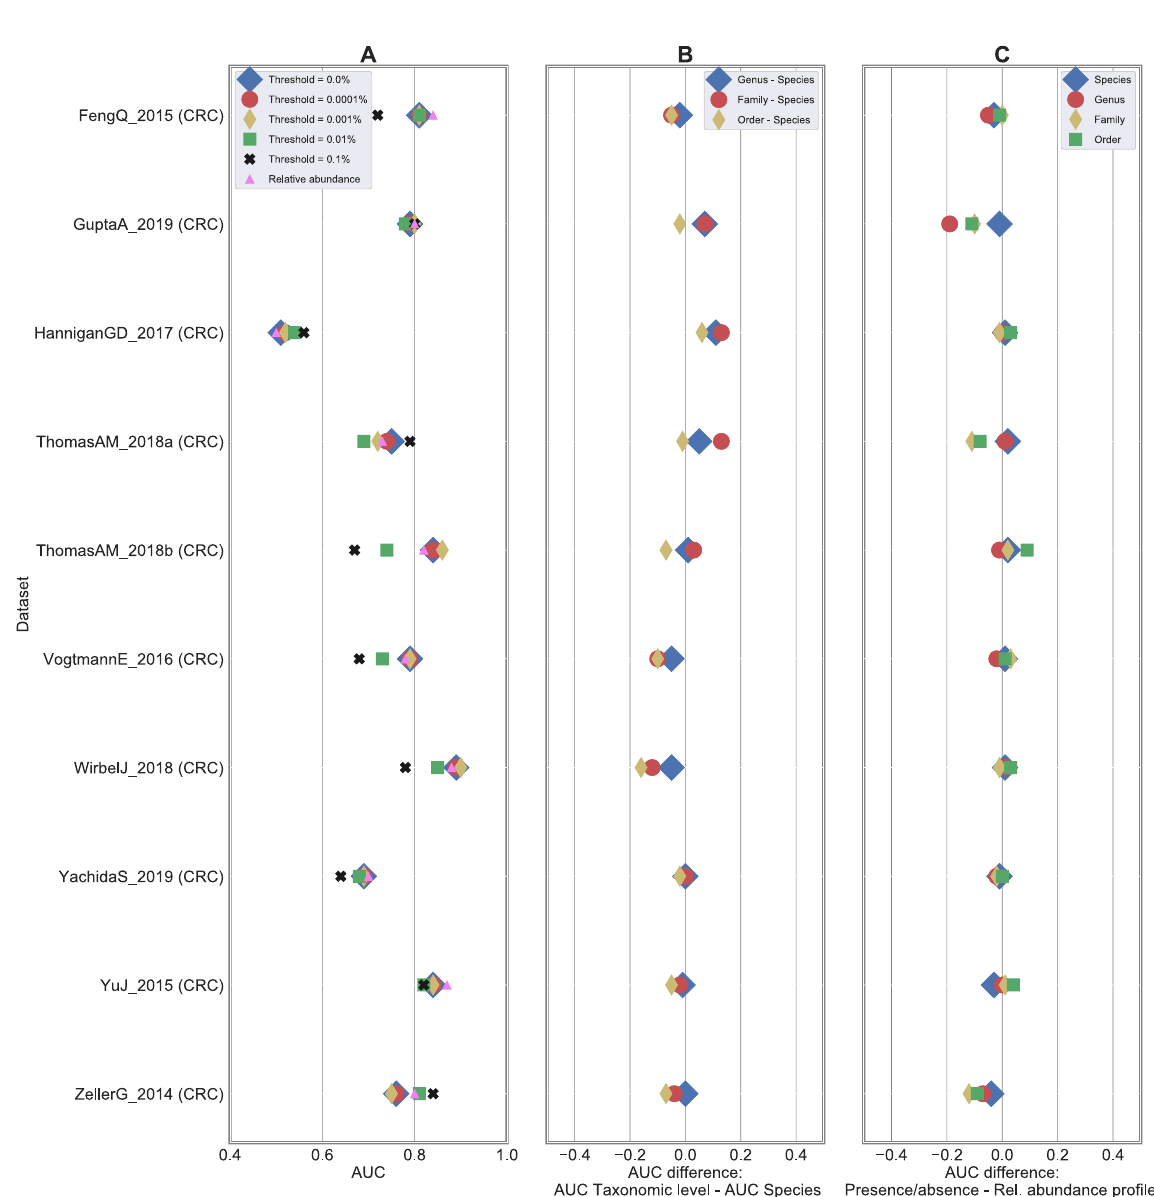
Fig 6. Degradation of relative abundance profiles does not impact LODO classification. Results in terms of leave-one-dataset-out (LODO) validation on 10 CRC shotgun datasets. ( A ) AUC scores using RF as back-end classifiers on species-level relative abundance (in pink) and presence/ absence profiles generated at different threshold values. ( B ) Difference in AUC between species and other taxonomic-level resolutions. A negative value indicates that species-level outperforms the comparison level. ( C ) Difference in AUC between presence/absence and relative abundance classification results at varying taxonomic